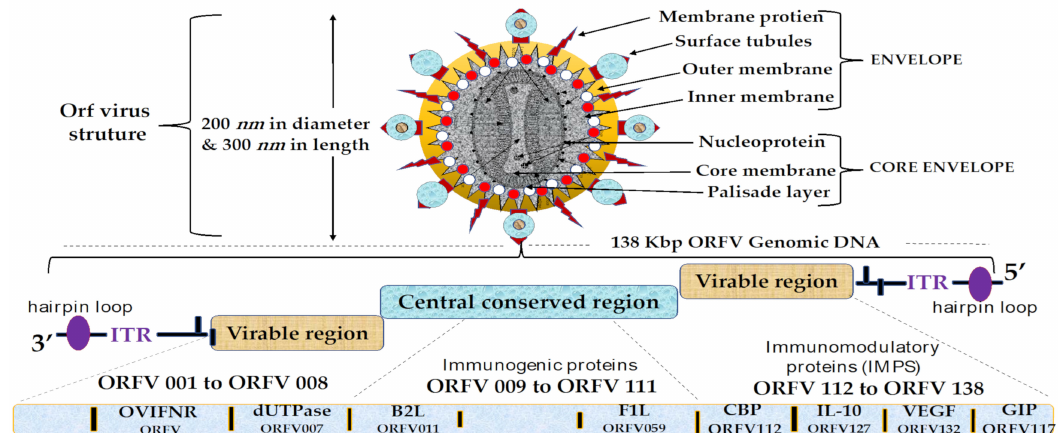
Figure 1. Schematic representation of the organization of ORFV genomic DNA. The 138 kb long linear ds-DNA genome comprises the central conserved region (ORFV009–ORFV111), the right end of the genome represents immunomodulatory proteins (ORFV112 to ORFV138), [84,88] and the left end another variable region (ORFV001 to ORFV008). The nucleocapsid protein holds the viral genome with inverted terminal repeats (ITRs) that closelyassociated with heparin loops at both the 3 (cid:48) and 5 (cid:48) ends. The highly variable regions are involved in the virulence and pathogenesis activities of the virus. The conserved region encoding 101 essential genes of the virus involved in immunogenicity, replication, transcription and morphogenesis